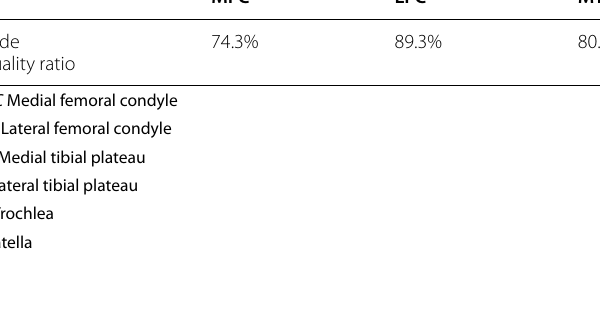
Table 5 The ratio of the grade equality in 6 recipient sites